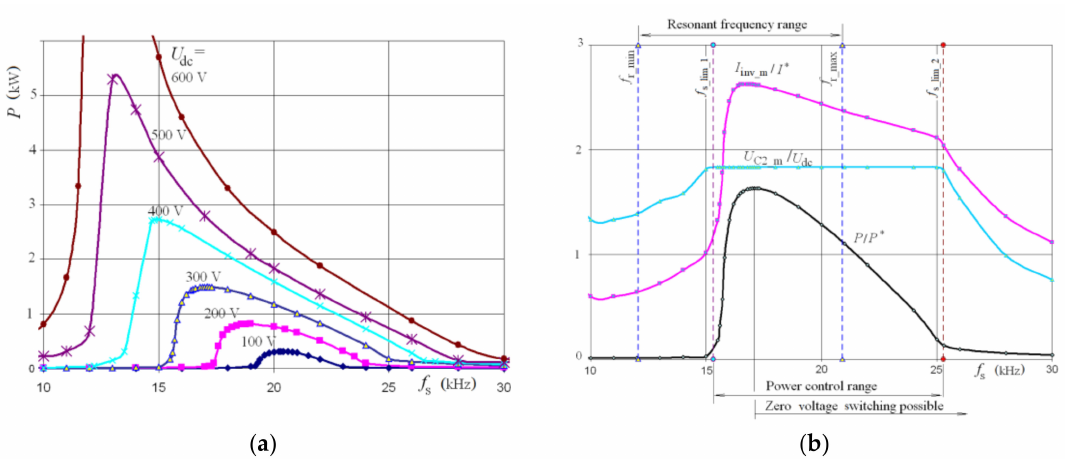
Figure 5. Characteristics of DBD discharges: ( a ) as a function of inverter output voltage and frequency, ( b ) as a function of inverter output frequency and constant inverter input voltage U dc = 300 V, reproducedfromPrzegl ˛adElektrotechniczny[34]; thesimulationresults; basevalues: I * = U dc / ( L r C 1 ’) 1 / 2 , P * = U dc2 / ( L r C 1 ’) 1 / 2